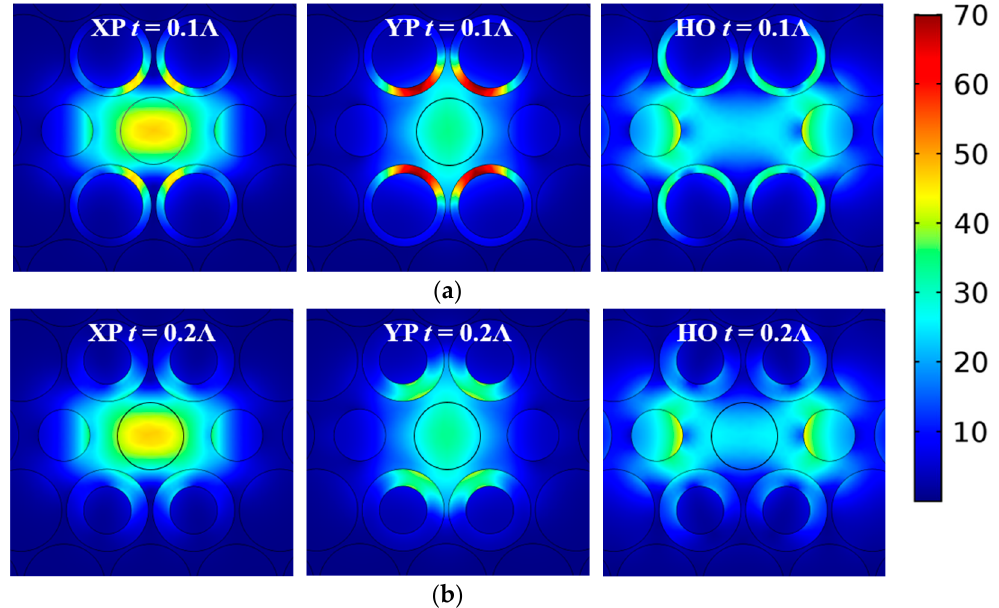
Figure 6. Simulated distributions of the magnitude of the total electric field of the XP, YP, and HO modes at 1.0 THz of the active ENZ-based PCF, with a ring thickness of ( a ) t = 0.1 Λ and ( b ) t = 0.2 Λ . (The scale bar is the same for all subplots.). Table 2. Crossover points, interval size, SPSM bandwidth, and MLD values for different ENZ ring thicknesses ( t ).